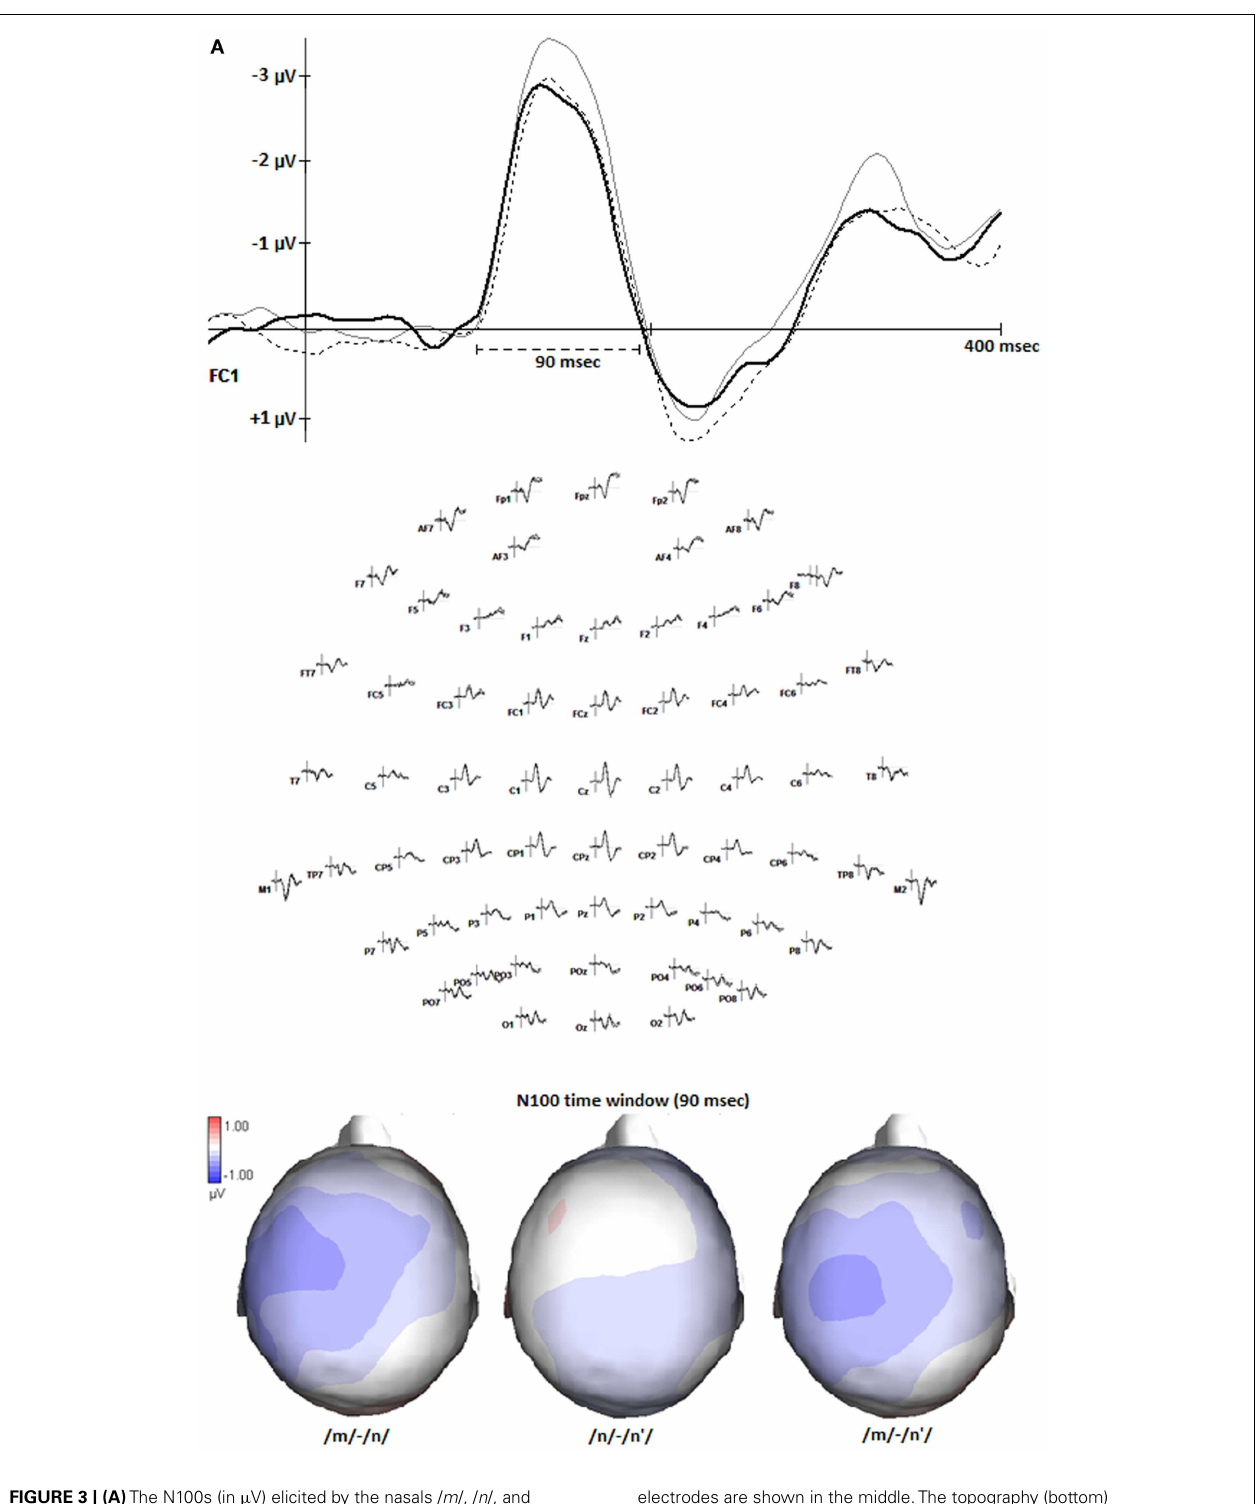
FIGURE 3 | (A) The N100s (in µ V) elicited by the nasals / m /, / n /, and / n (cid:48) / when presented in isolation.The ERP-graph (upper picture) shows the activation at exemplar electrode FC1, marking the N100-time window of 90ms used for the analyses (top). All